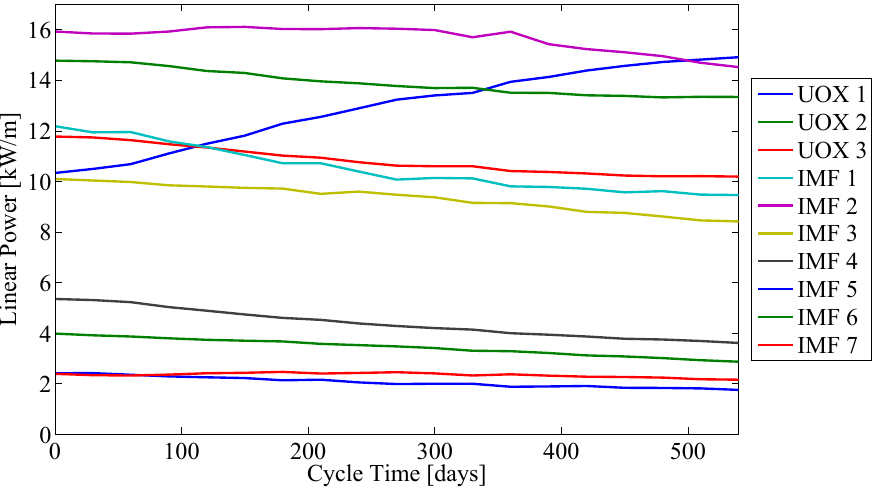
Figure 10. Assembly level power. The power from each assembly within the core changes over the course of the